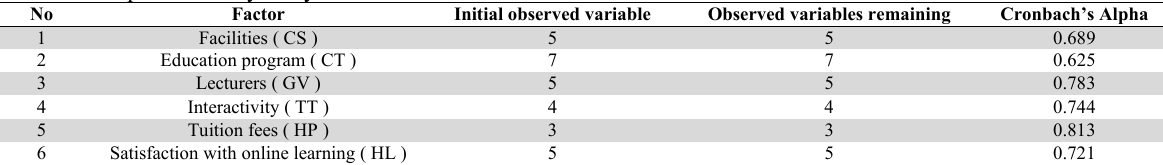
Cronbach's Alpha reliability analysis results